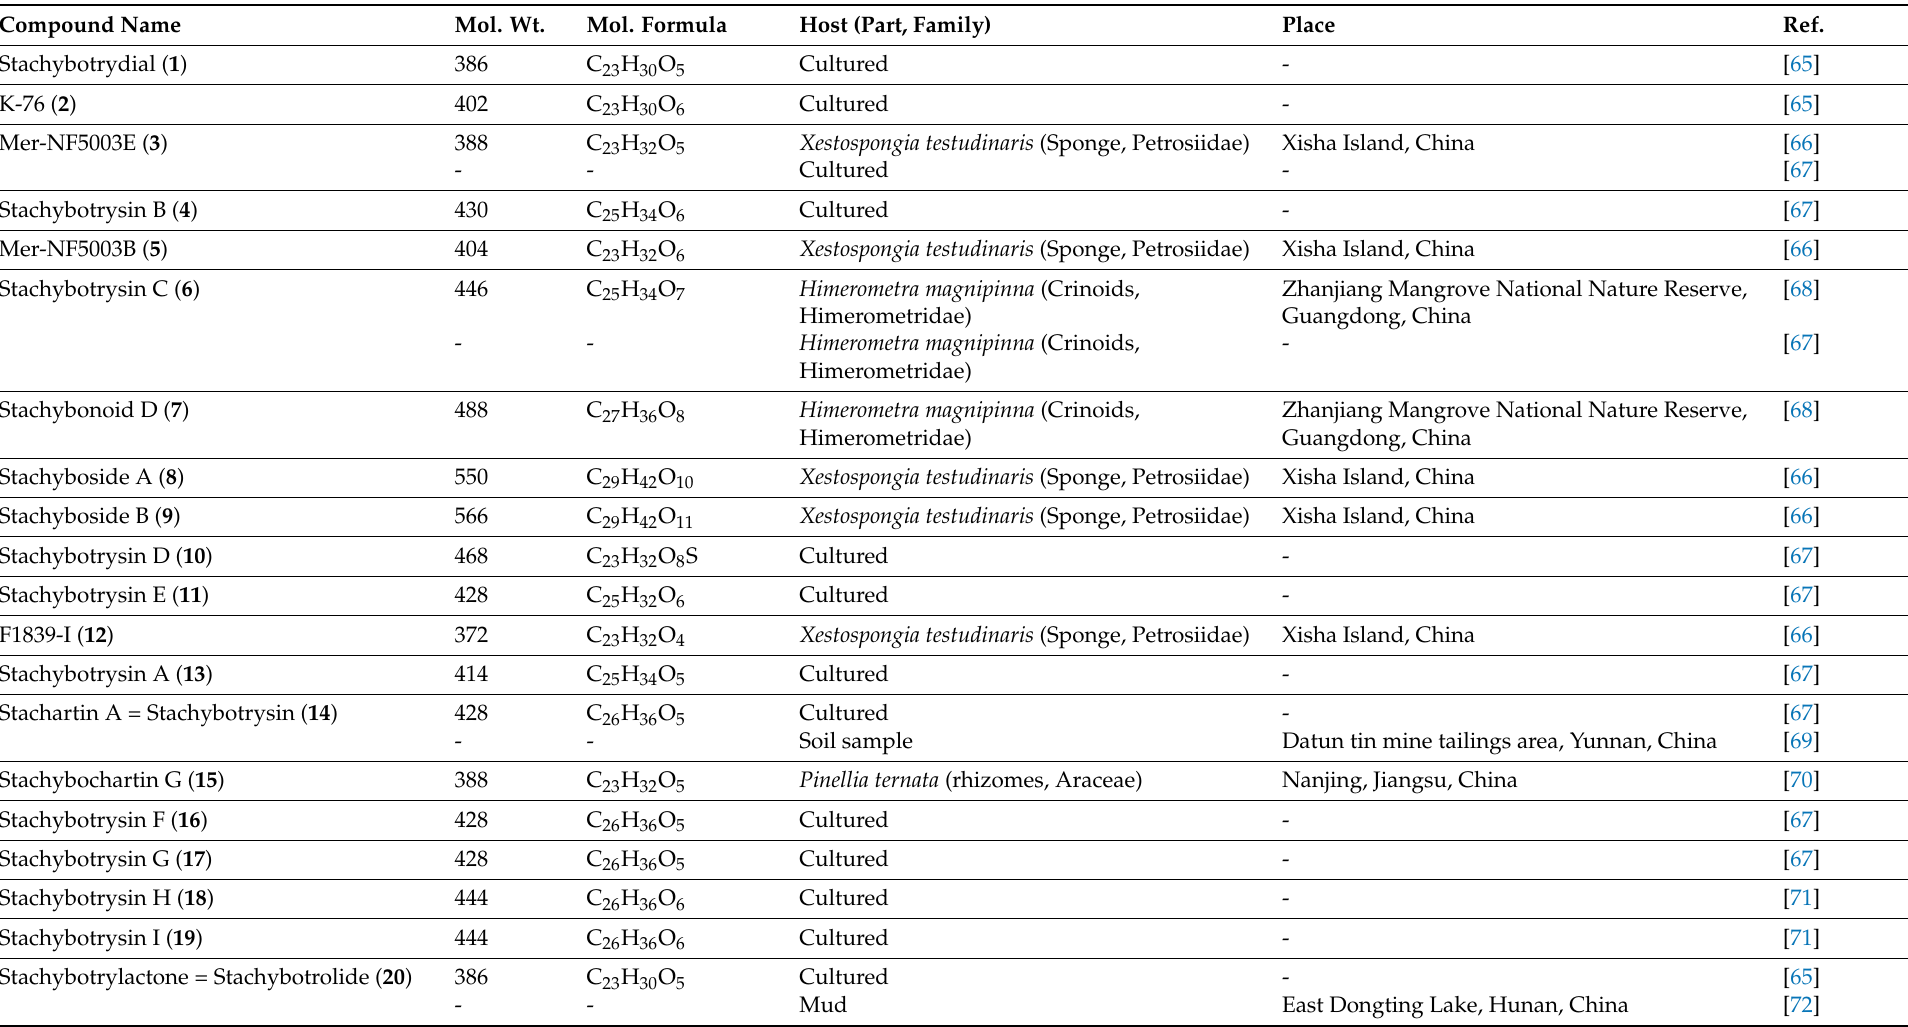
Table 1. List of compounds isolated from Stachybotrys chartarum